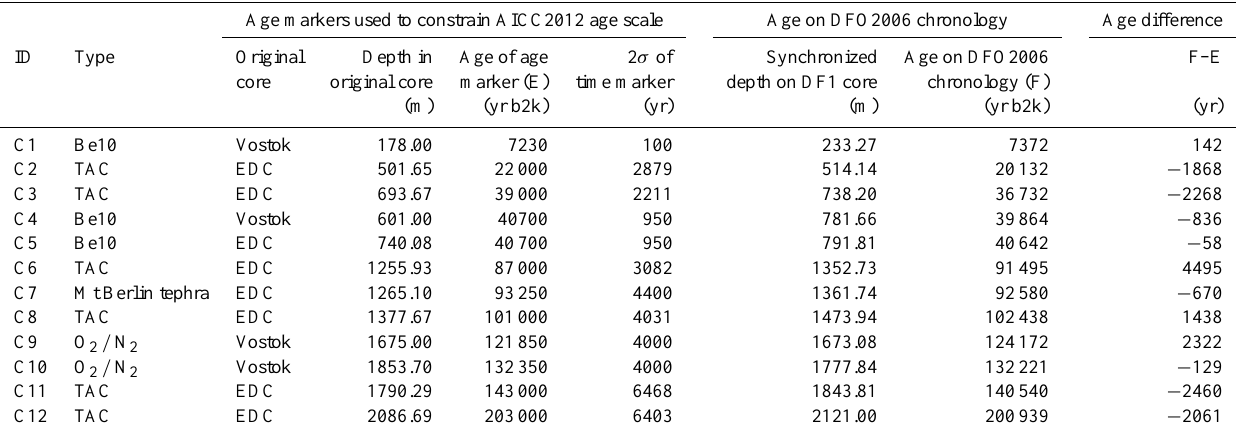
Table 4. Depths and DFO2006 ages of DF core at depth/age of age markers of AICC2012